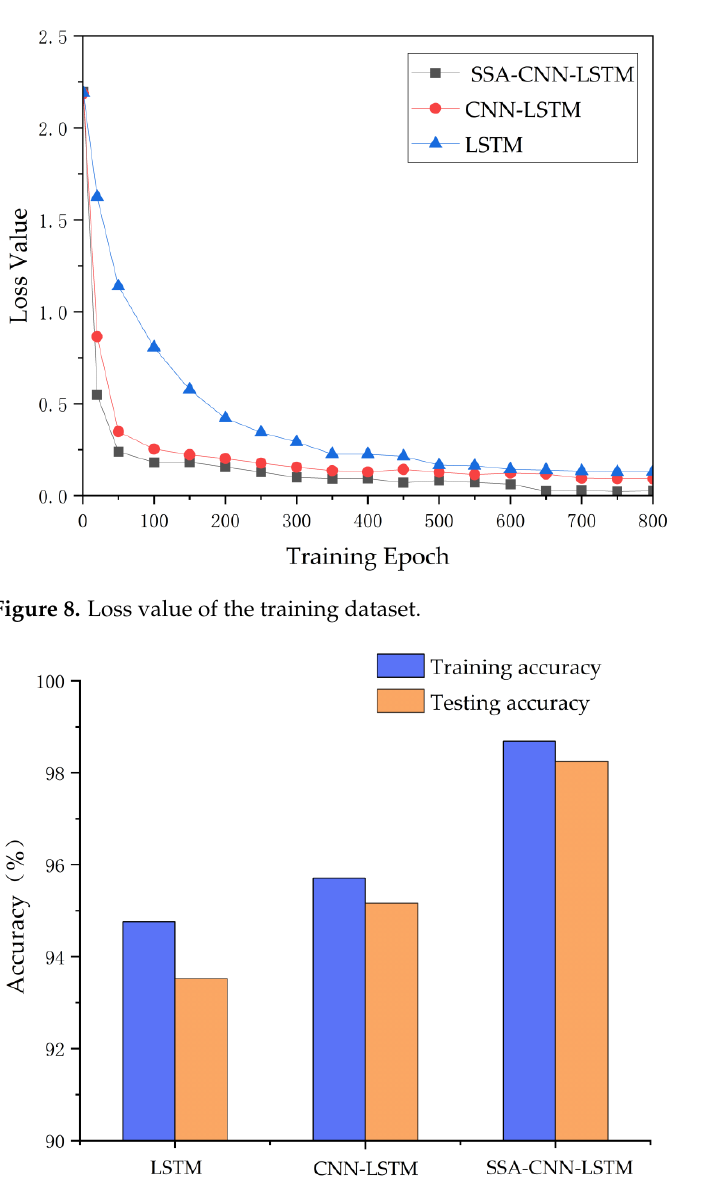
Figure 9. Training and testing accuracy of the models.